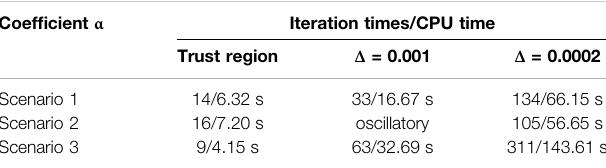
TABLE 5 | Relationship between active power loss and maximum reactive compensation capability.